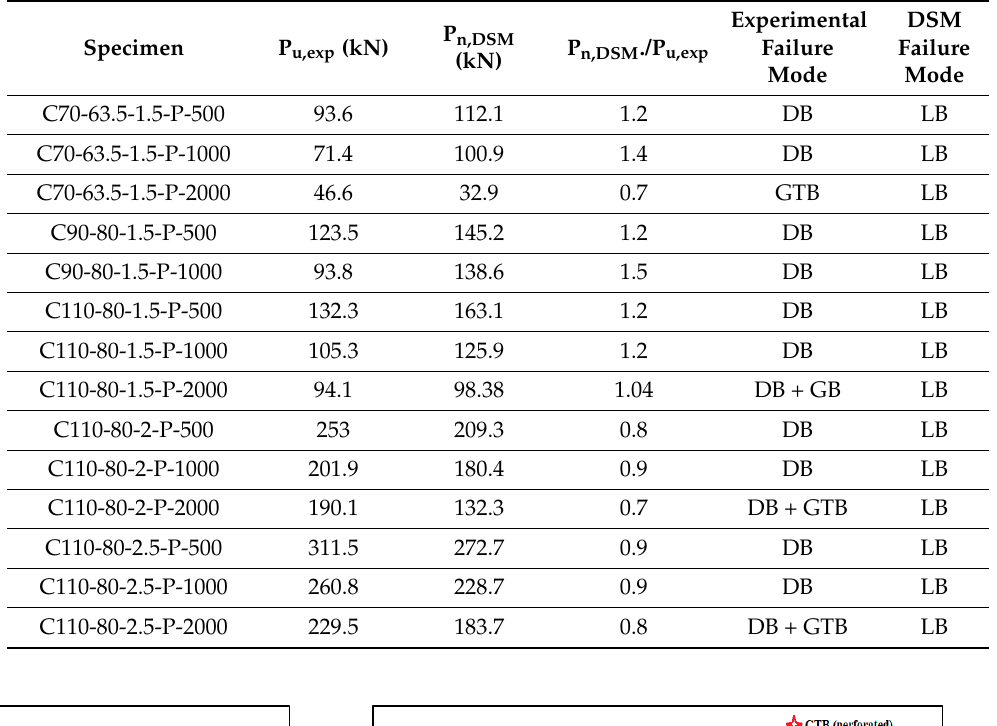
Table 4. Comparison between the results of f experimental and DSM.